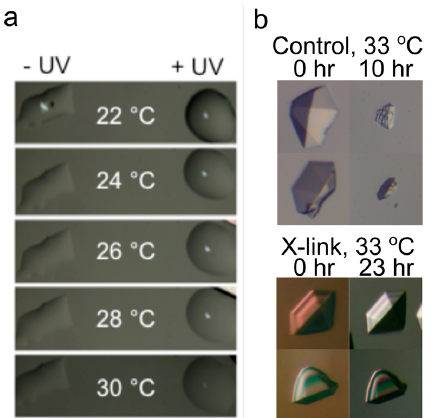
Figure 8. Crosslinking enhances DNA crystal thermostability. ( a ) Site-specific introduction of photo crosslinking groups to the tensegrity triangle crystals through triplex formation enhances crystal stability in a UV-dependent manner. ( b ) Comparison of 13-mer DNA crystals with and without nornitrogen mustard crosslinking following incubation at 33 °C at the specified times.